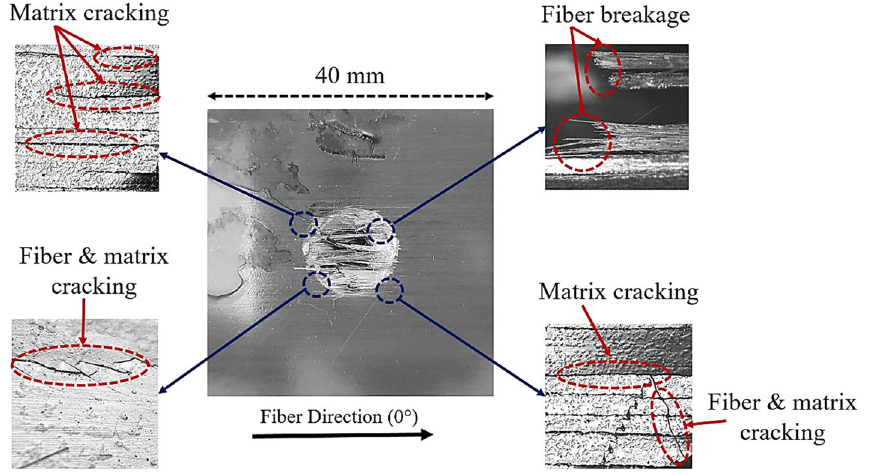
Figure 8. Damages on the top face of fully dry composite plate ( Q 1